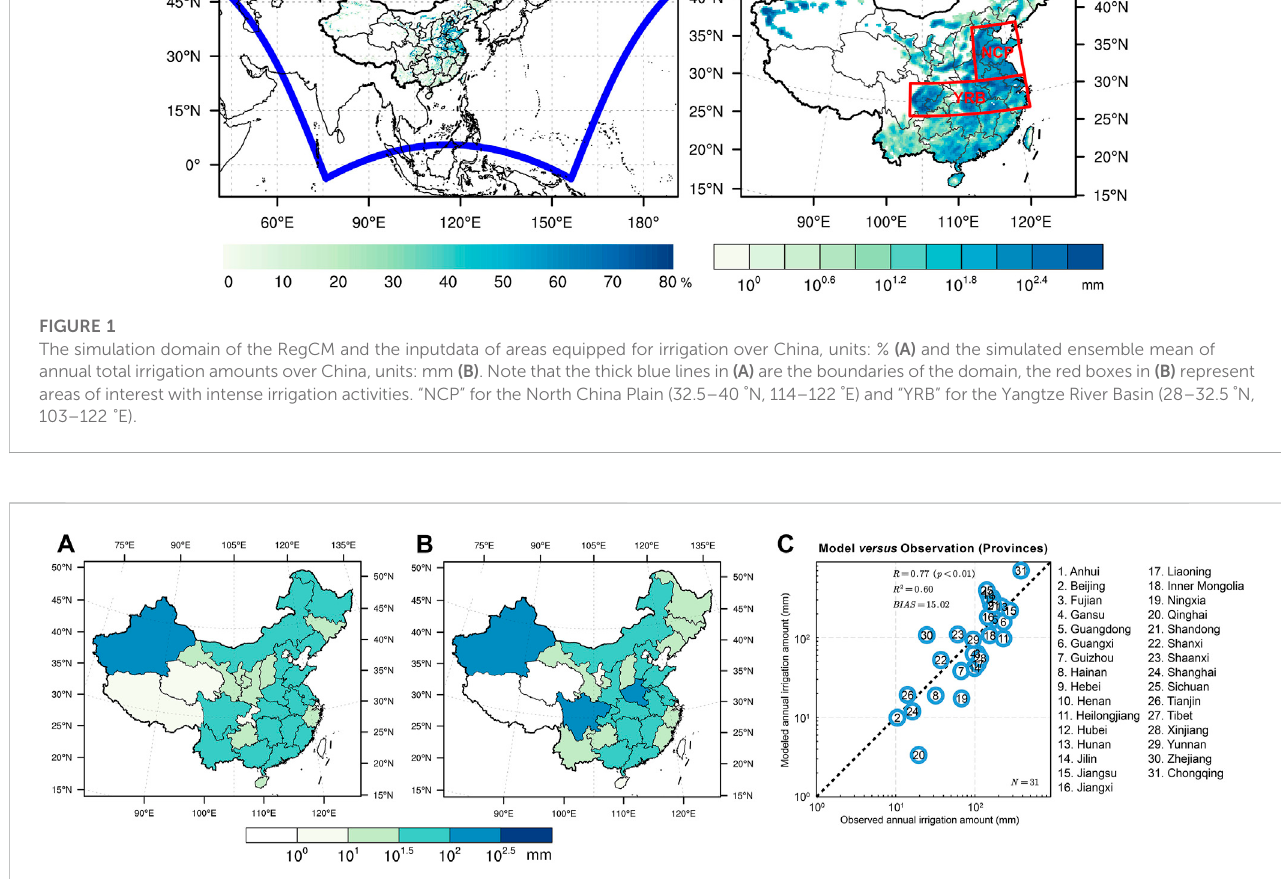
FIGURE 2 Comparison of observed and modeled multi-year average annual irrigation amount (units: mm) at the provincial scale: (A) observedvalues; (B) modeled values; (C) scatterplotofobserved versus modeledirrigation.Notethatthe R , R 2 , BIAS and N in (C) representthecorrelation,R-Squared,absoluteerrorandthe number of data involved, respectively. The numbers in the hollow points in (C) represent the different provinces (see the list on the right side of (c)).